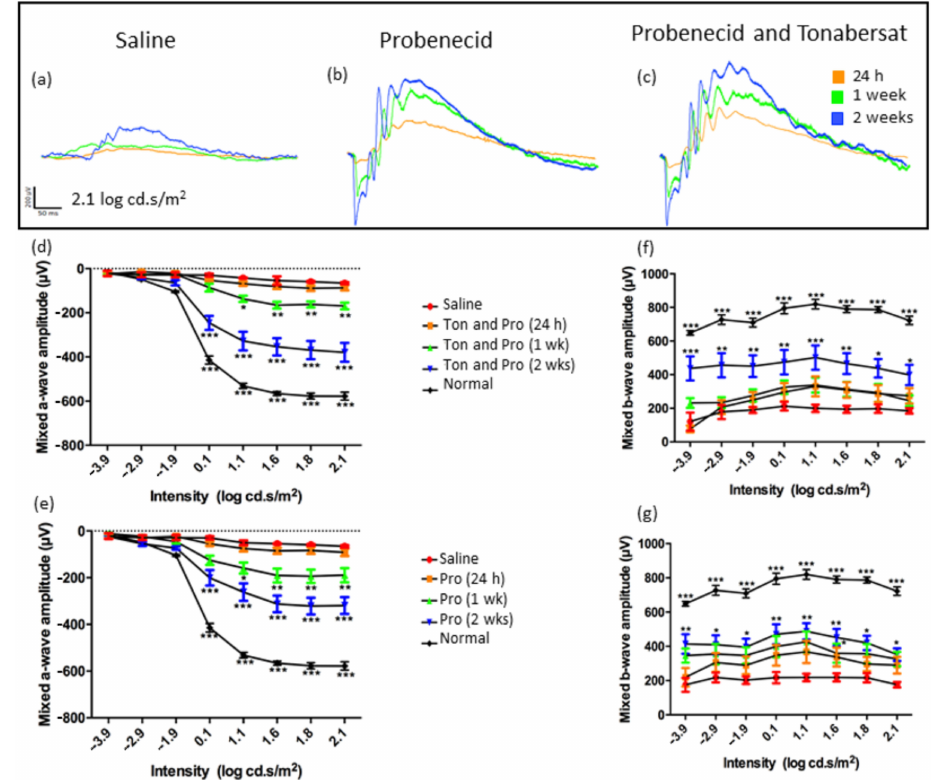
Figure 1. Differential effect of pannexin channel inhibitor (1 mM probenecid) in combination with connexin hemichannel block (30 µ M tonabersat) and pannexin channel block alone (1 mM) on ERG amplitude. Representative ERG amplitudes obtained at 24 h, 1 week and 2 weeks post-treatment or saline (trace shown at 2 weeks post-injury) intraperitoneal injection in the intense light-exposed rat ( a – c ). The a-wave amplitude of the ERG in rats treated with a combination of tonabersat and probenecid ( d ) or probenecid alone ( e ). The b-wave amplitude of the ERG is shown for the tonabersat with probenecid ( f ) or probenecid-only treated rats ( g ). The graphs include the results from saline injection in the light-damaged rats (red; shown here at the 2-week time point) and the ERG response in normal uninjured rats (black). Saline injection data and control animals’ responses are plotted in all